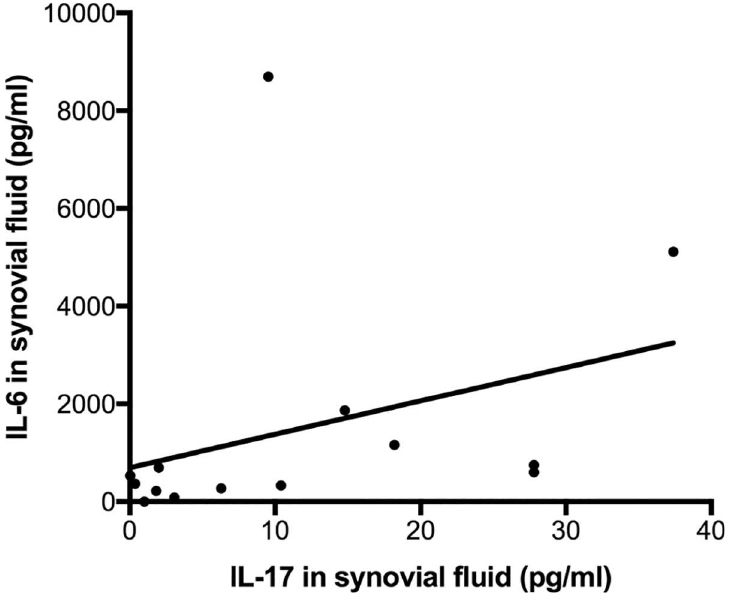
Fig 4. Correlation between synovial fluid IL-17 and IL-6 concentrations in patients with detectable IL- 17 in synovial fluid.